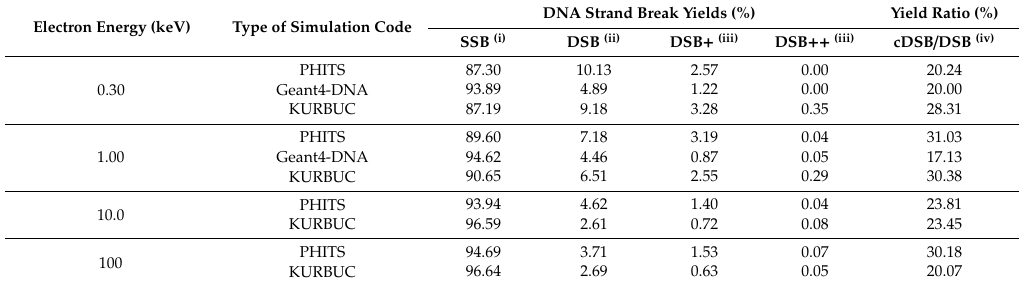
Table 3. Benchmark test for complex double-strand break (DSB) compared to the other simulations. Electron Energy